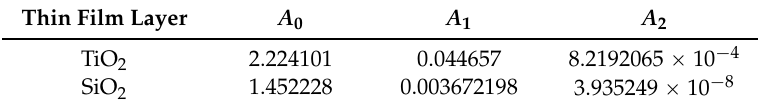
Table 4. Cauchy parameters for the TiO 2 and SiO 2 coating